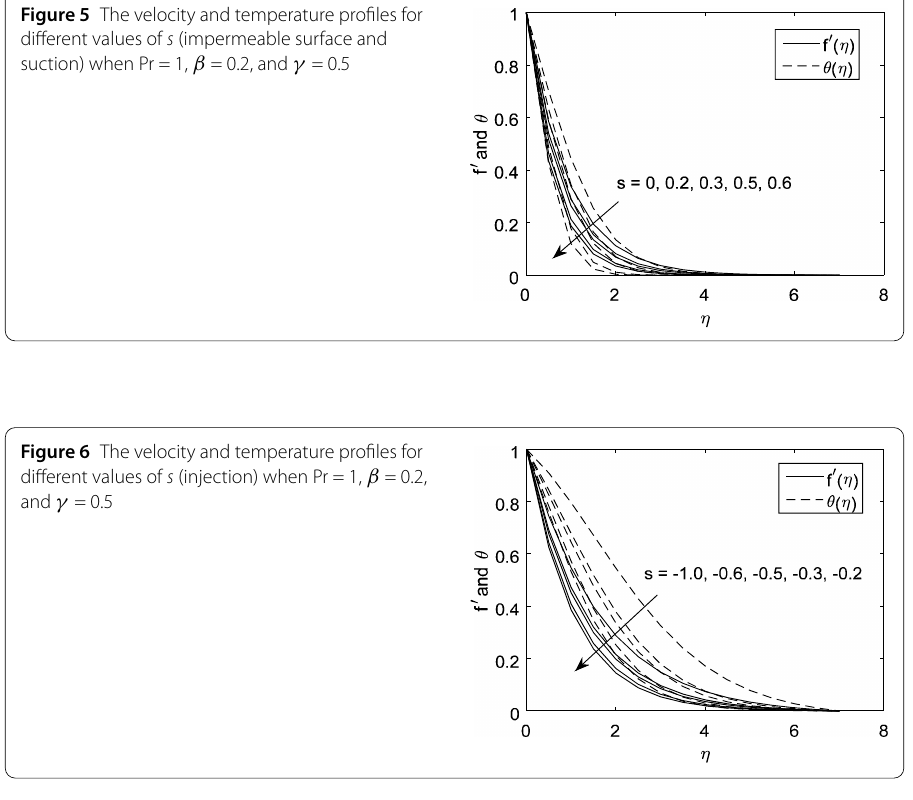
Figure 5 The velocity and temperature profiles for different values of s (impermeable surface and suction) when Pr = 1, β = 0.2, and γ = 0.5